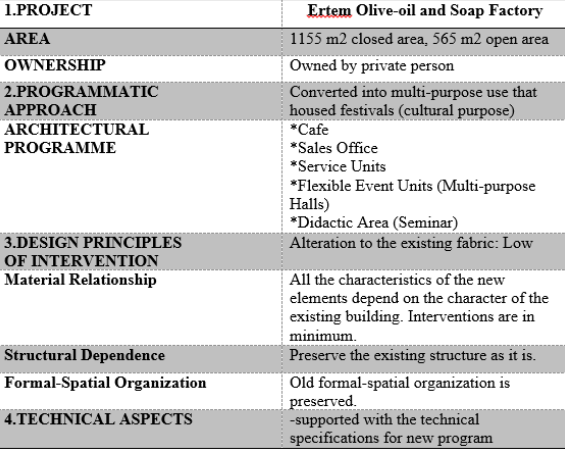
Table 1 : Conservation Proposal for Ertem Olive Oil